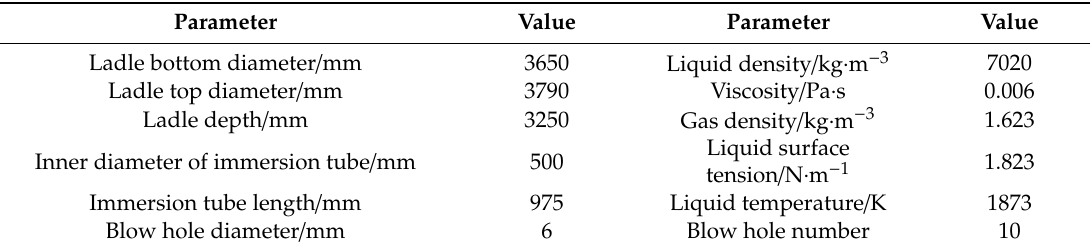
Figure 3. Geometric model and grid of the whole RH plant. Table 4. Physical parameters for RH